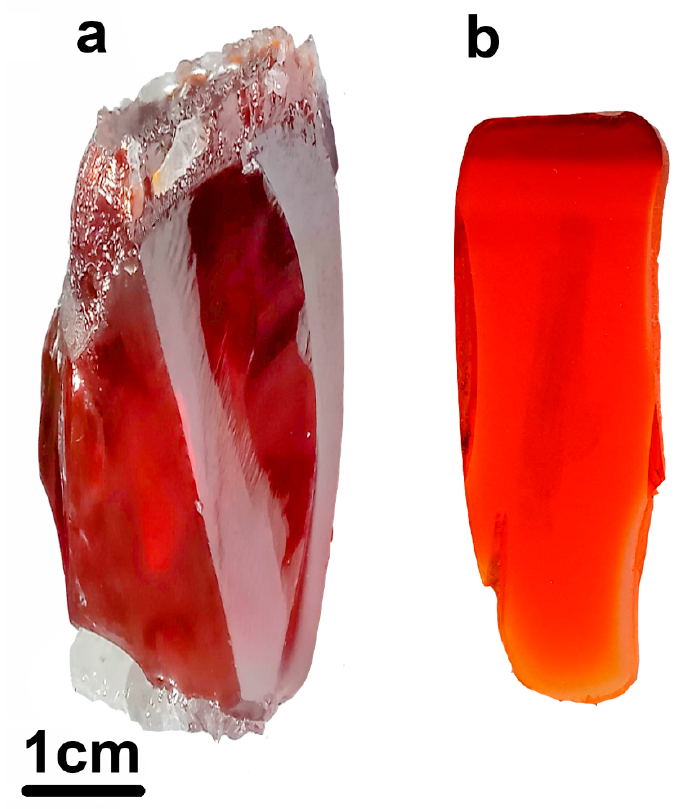
Figure 1. Appearance ( a ) and cross-section ( b ) of as-grown crystal.